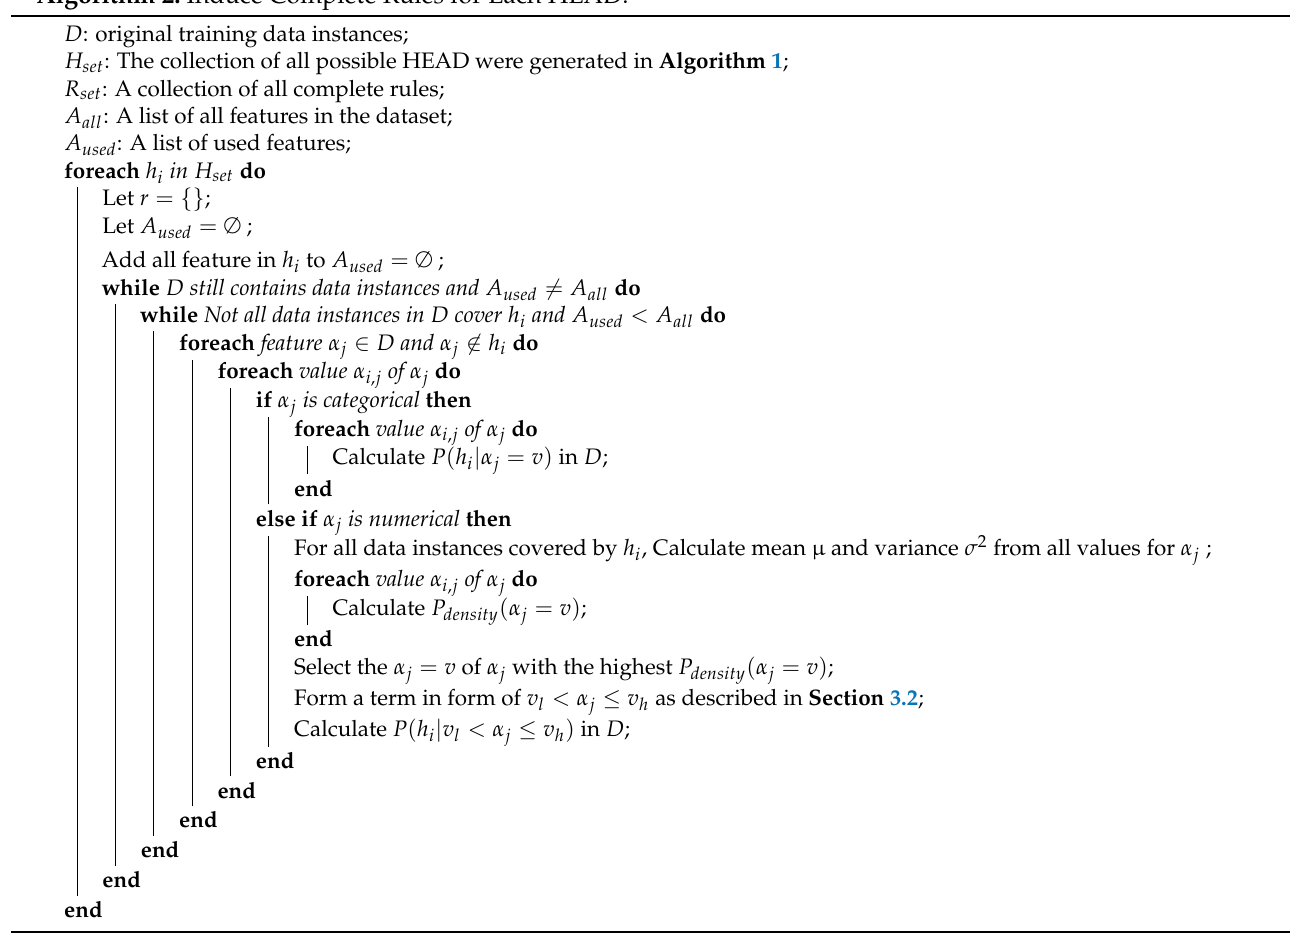
Algorithm 2: Induce Complete Rules for Each